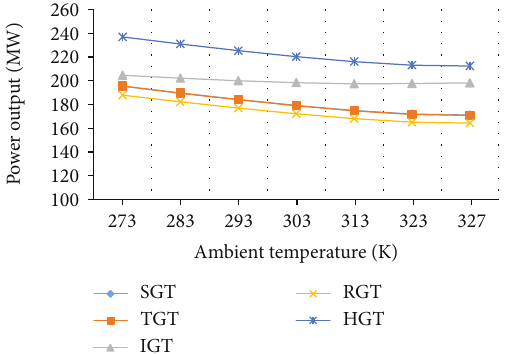
Figure 8: The relation between the output power and the ambient temperature for the predicted results and the actual data from the Baiji Gas-Turbine power